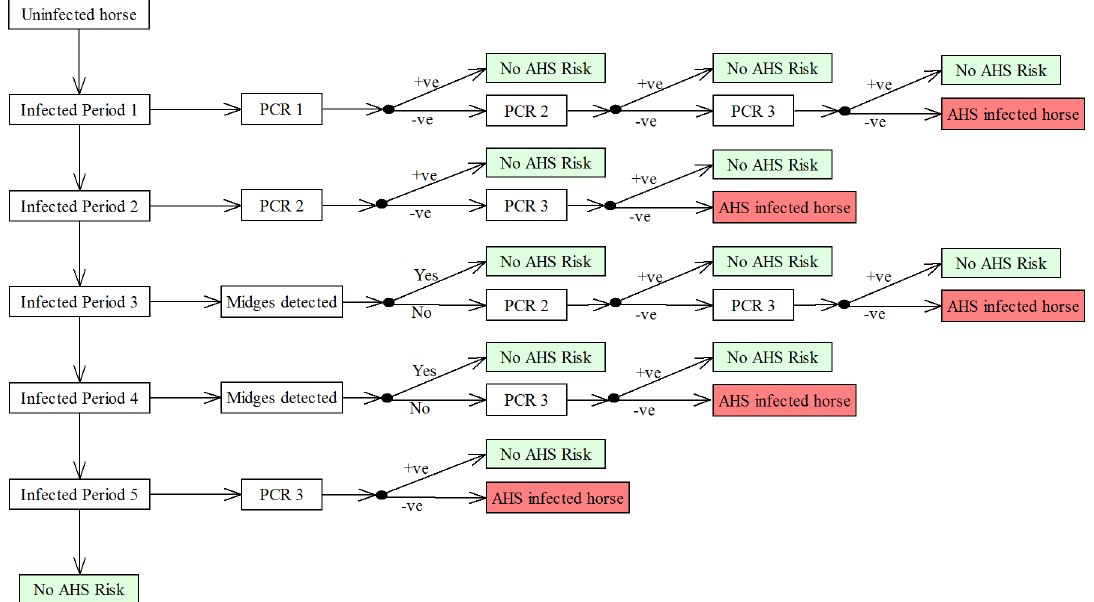
Fig 2. Scenario tree depicting pathways by which an undetected AHSV-infected horse could be exported from South Africa.